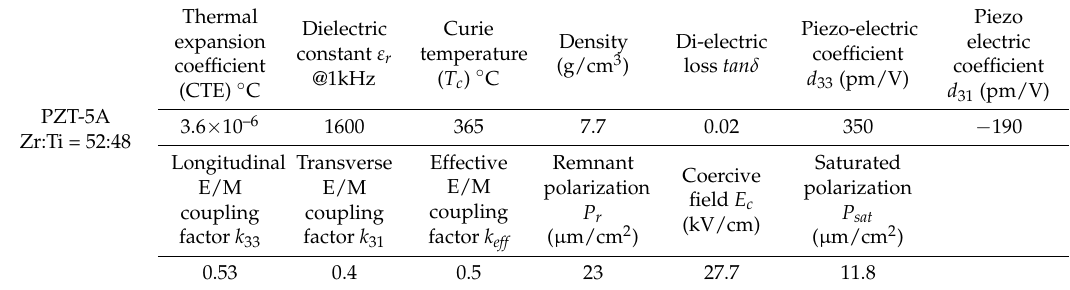
Table 1. Physical, dielectric and piezoelectric properties of PZT-5A free samples [31].